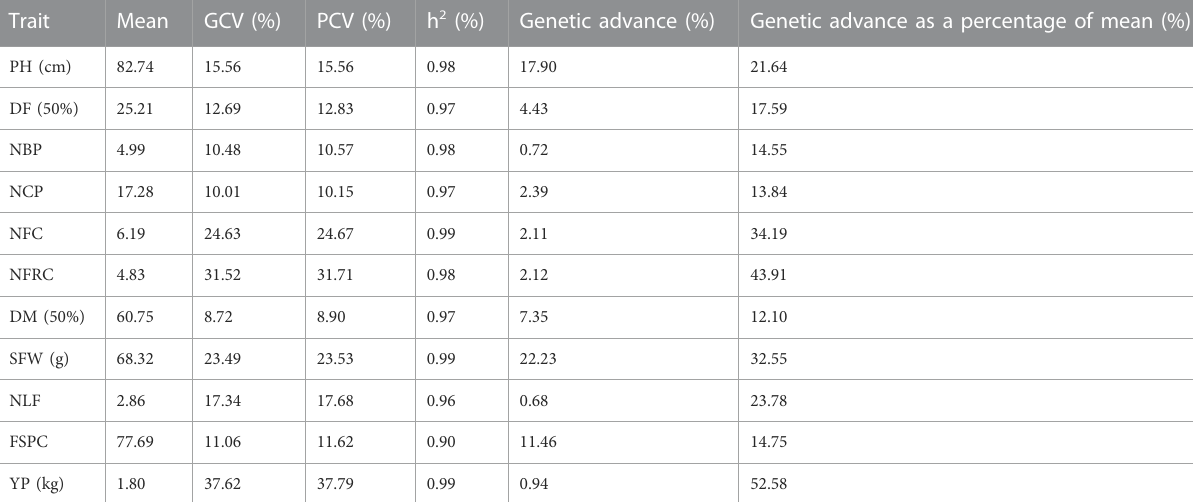
TABLE 5 Genetic variability, heritability, and genetic advance for yield-related traits in tomatoes. Trait Genetic advance (%) Genetic advance as a percentage of mean